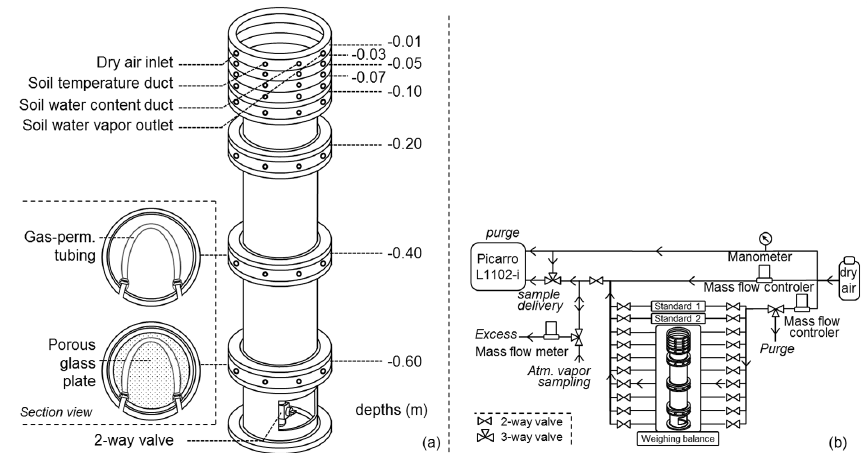
Figure 1. (a) Scheme of the acrylic glass column used in the experiment; (b) experimental setup for sampling water vapor at the different soil depths of the soil column: from the ambient air, and from the two soil water standards (standard 1 and